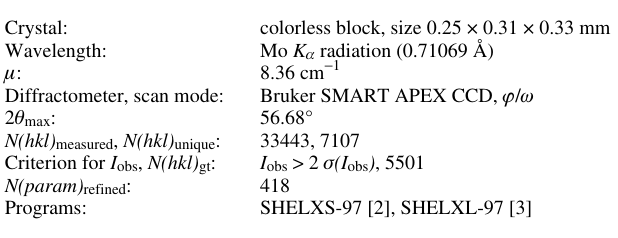
Table 1. Data collection and handling.